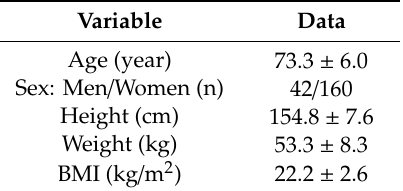
Table 1. Demographic characteristics of the 202